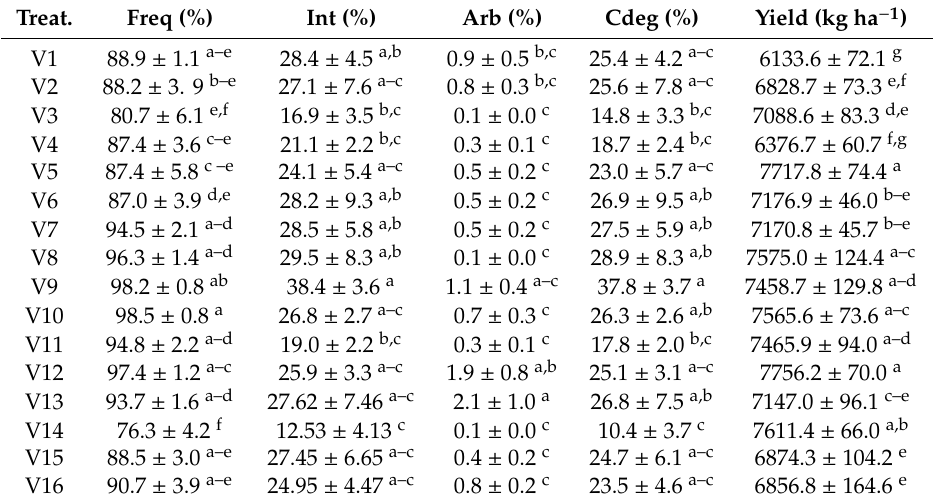
Table 2. The impact of fertilization on arbuscular mycorrhiza colonization and crop yield of winter